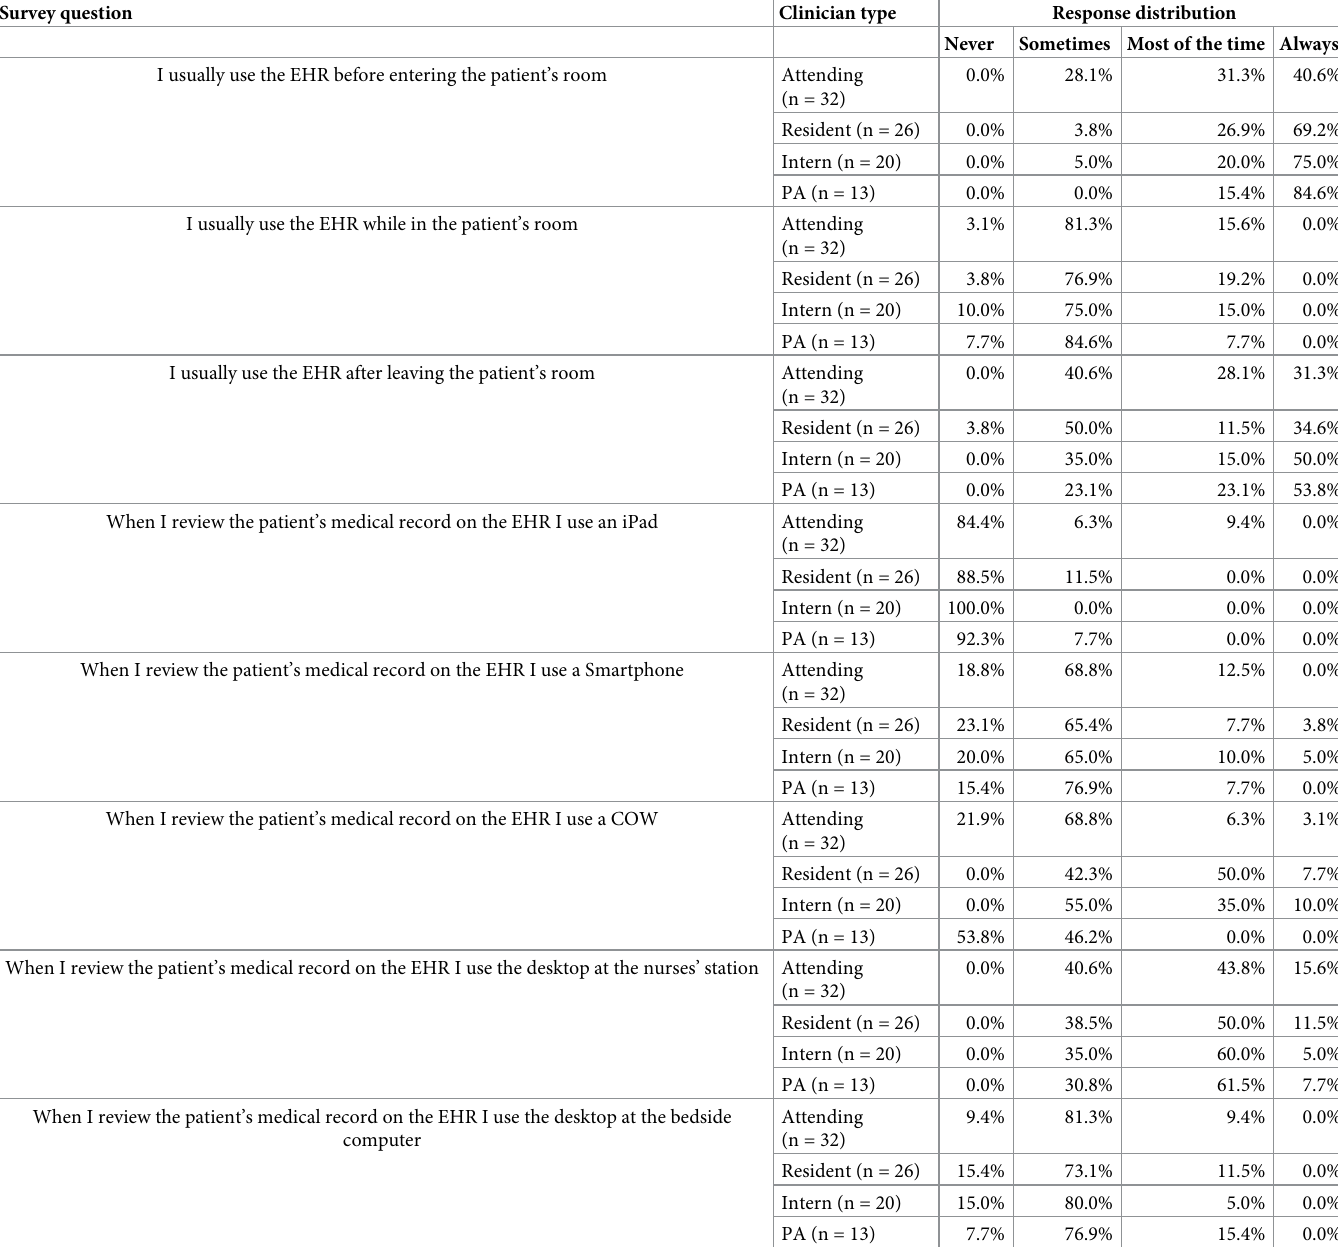
Table 2. EHR use patterns during morning rounds: Survey responses based on clinician